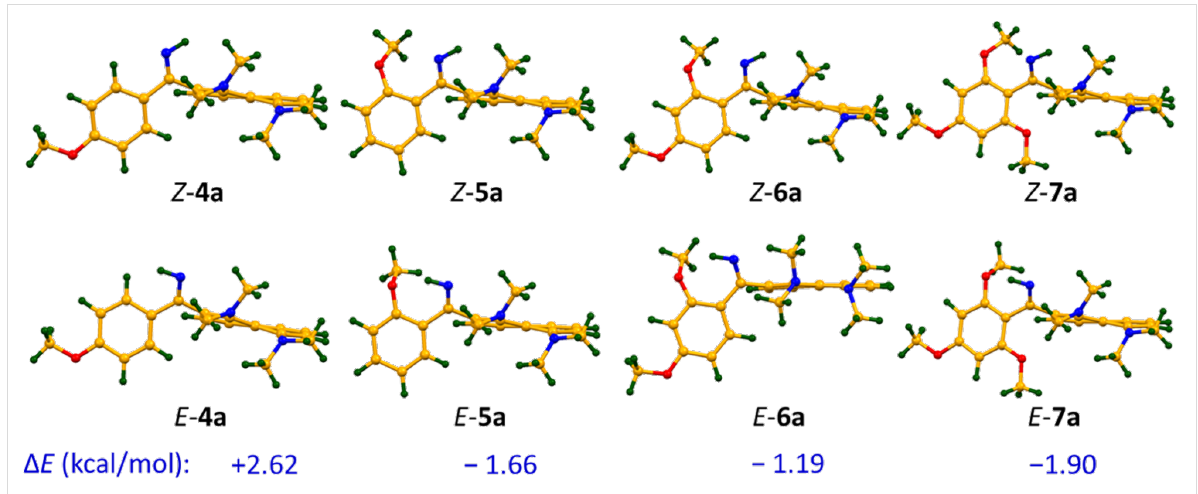
Figure 3: Optimised geometry and energy difference Δ E = E E – E Z (kcal/mol) for imines 4a – 7a (B3LYP/6-311+G(d,p)).